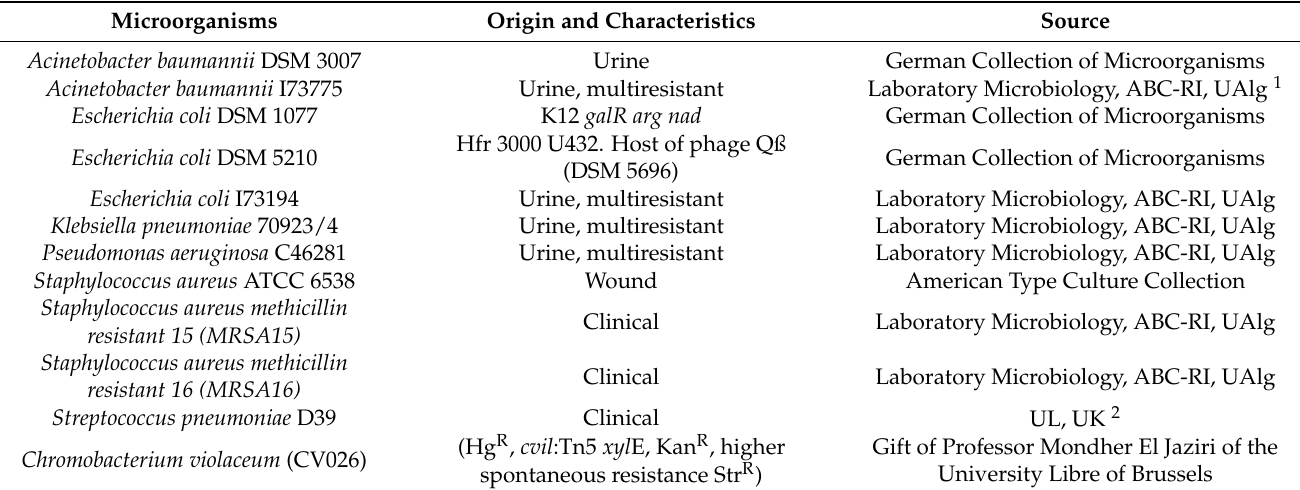
Table 1. Microorganisms used in the study.